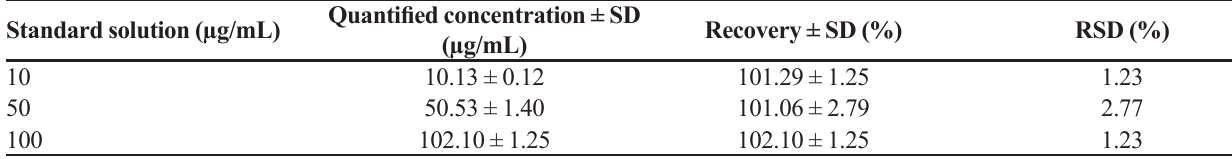
TABLE III - Percent recovery and RSD obtained by the accuracy test (n=5) Standard solution (µg/mL)